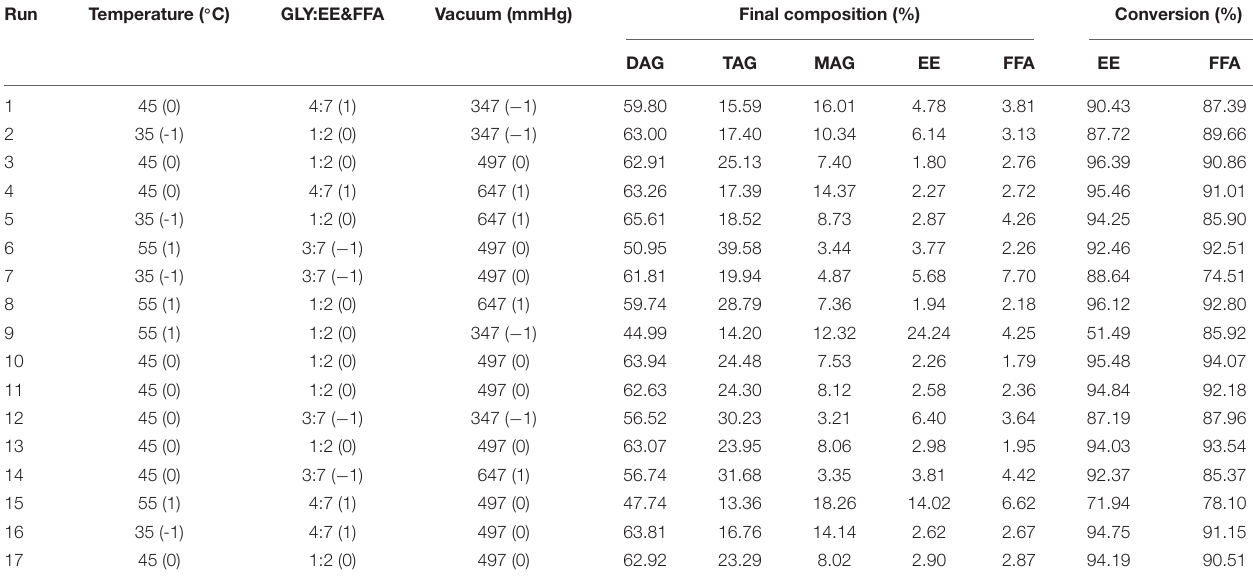
TABLE 1 | Response surface methodology (RSM) design and corresponding results of diacylglycerol (DAG) yield and the conversion of EE and FFA. Run Temperature ( ◦